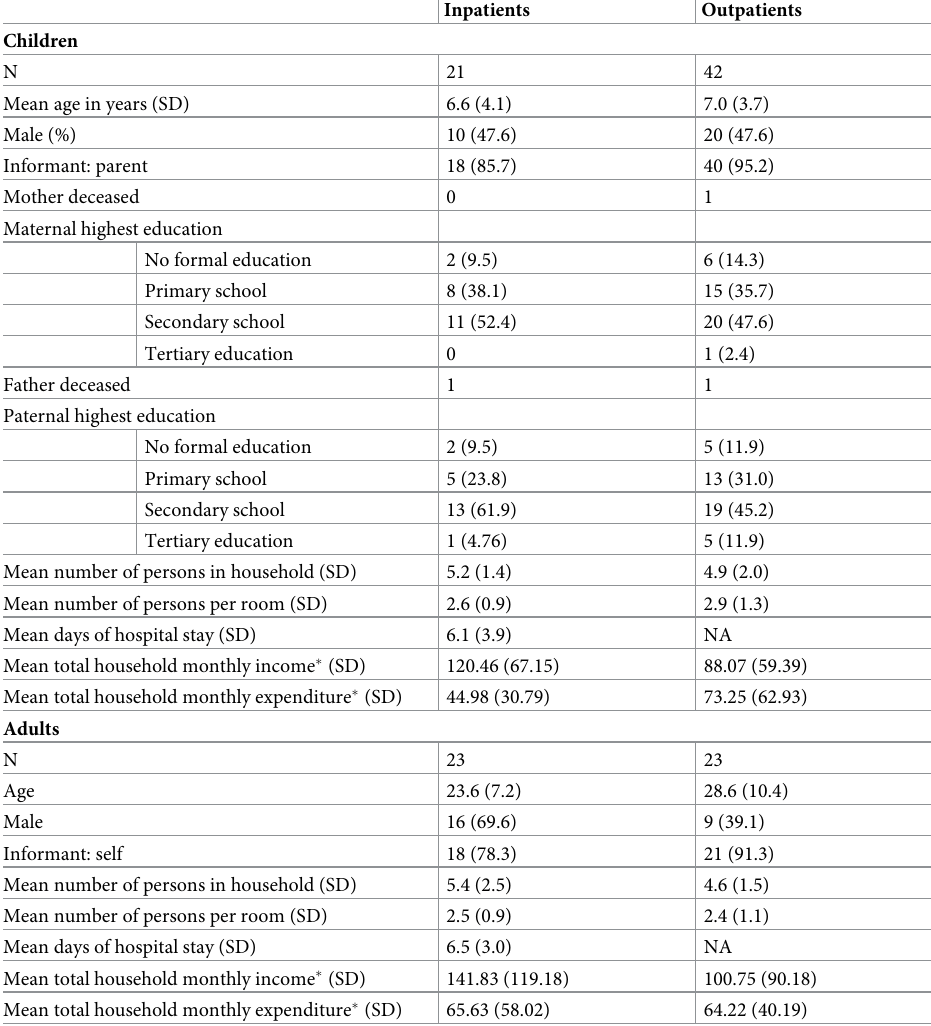
Table 1. Participant